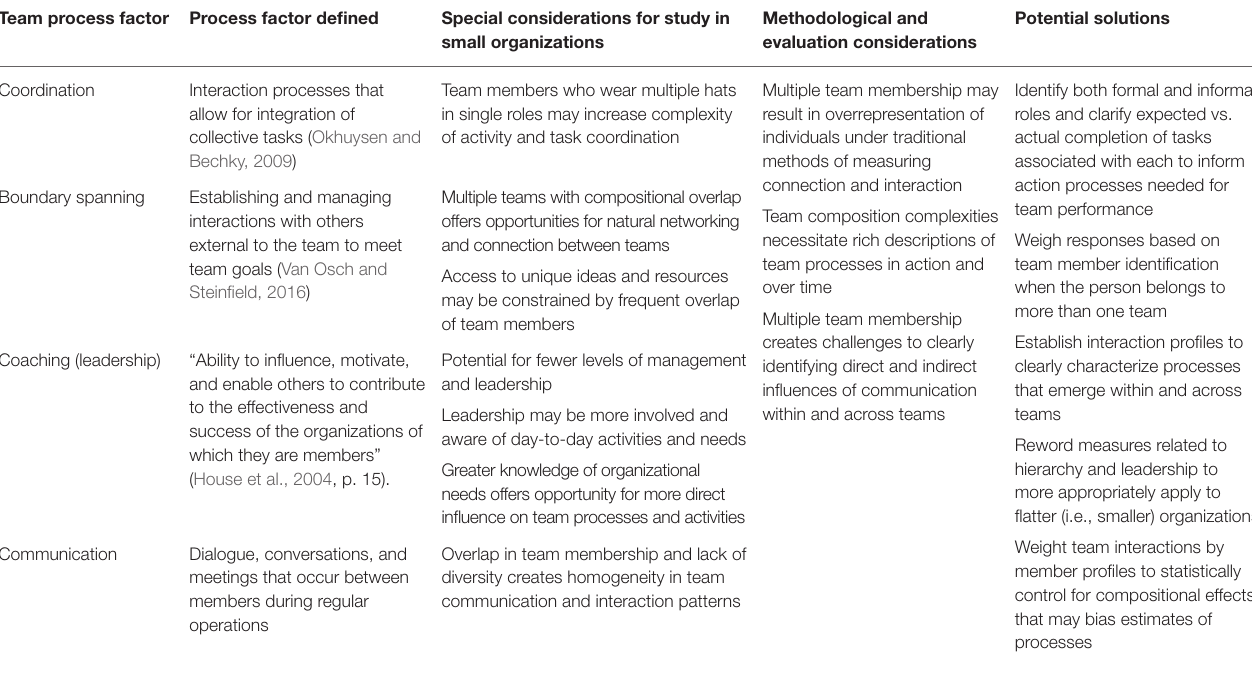
TABLE 3 | Team process methodological considerations for teams in small organizations. Team process factor Process factor